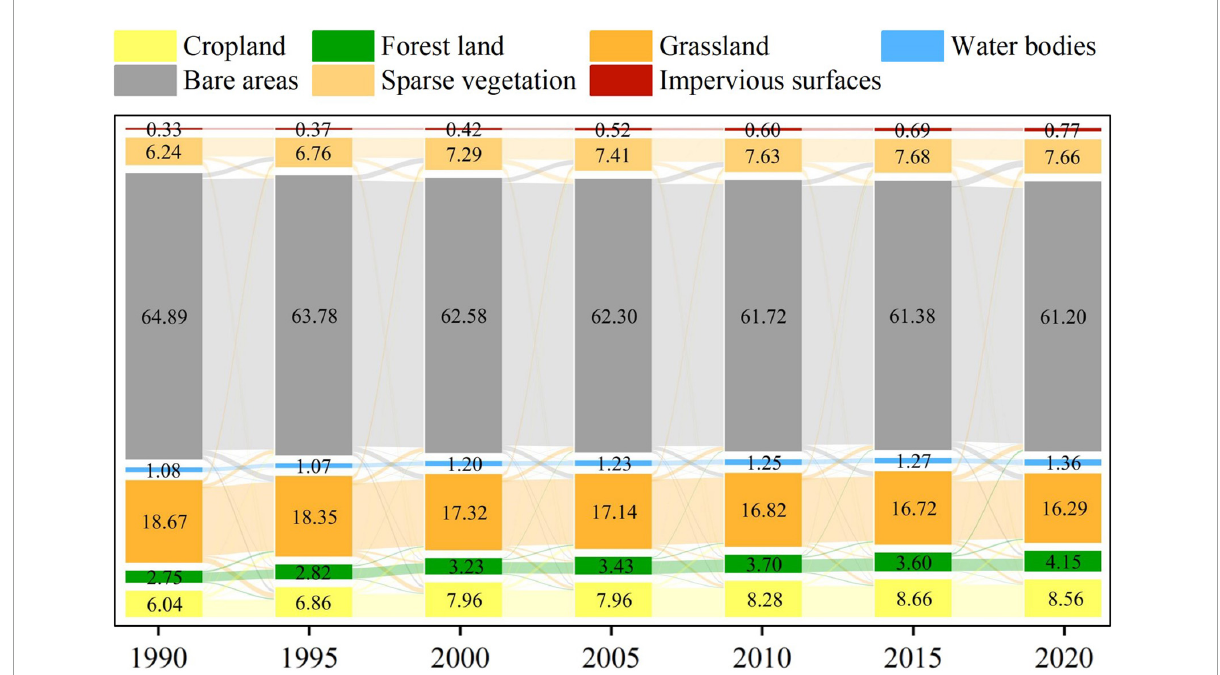
FIGURE2 Sankey plot of land use change in the NSTM. Stacked vertical bars represent the proportions of various land use types from 1990 to 2020. Lines between each pair of bars visualize the changes of each land use type in the 5-year interval. The thickness of each line represents the proportion of the corresponding land-use area that experiences the persistence or